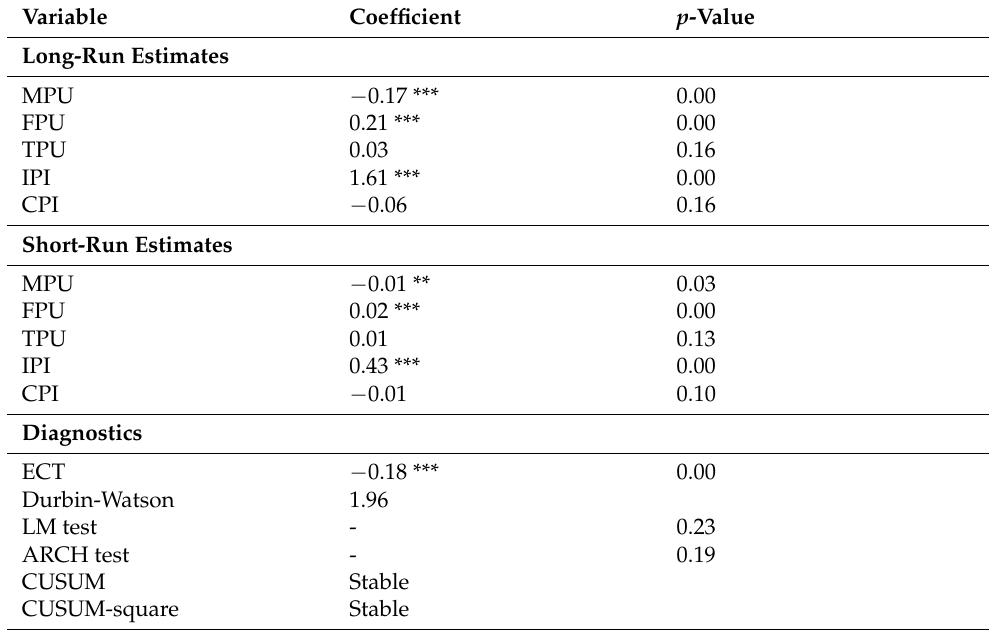
Table 5. Short- and Long-Run Results.